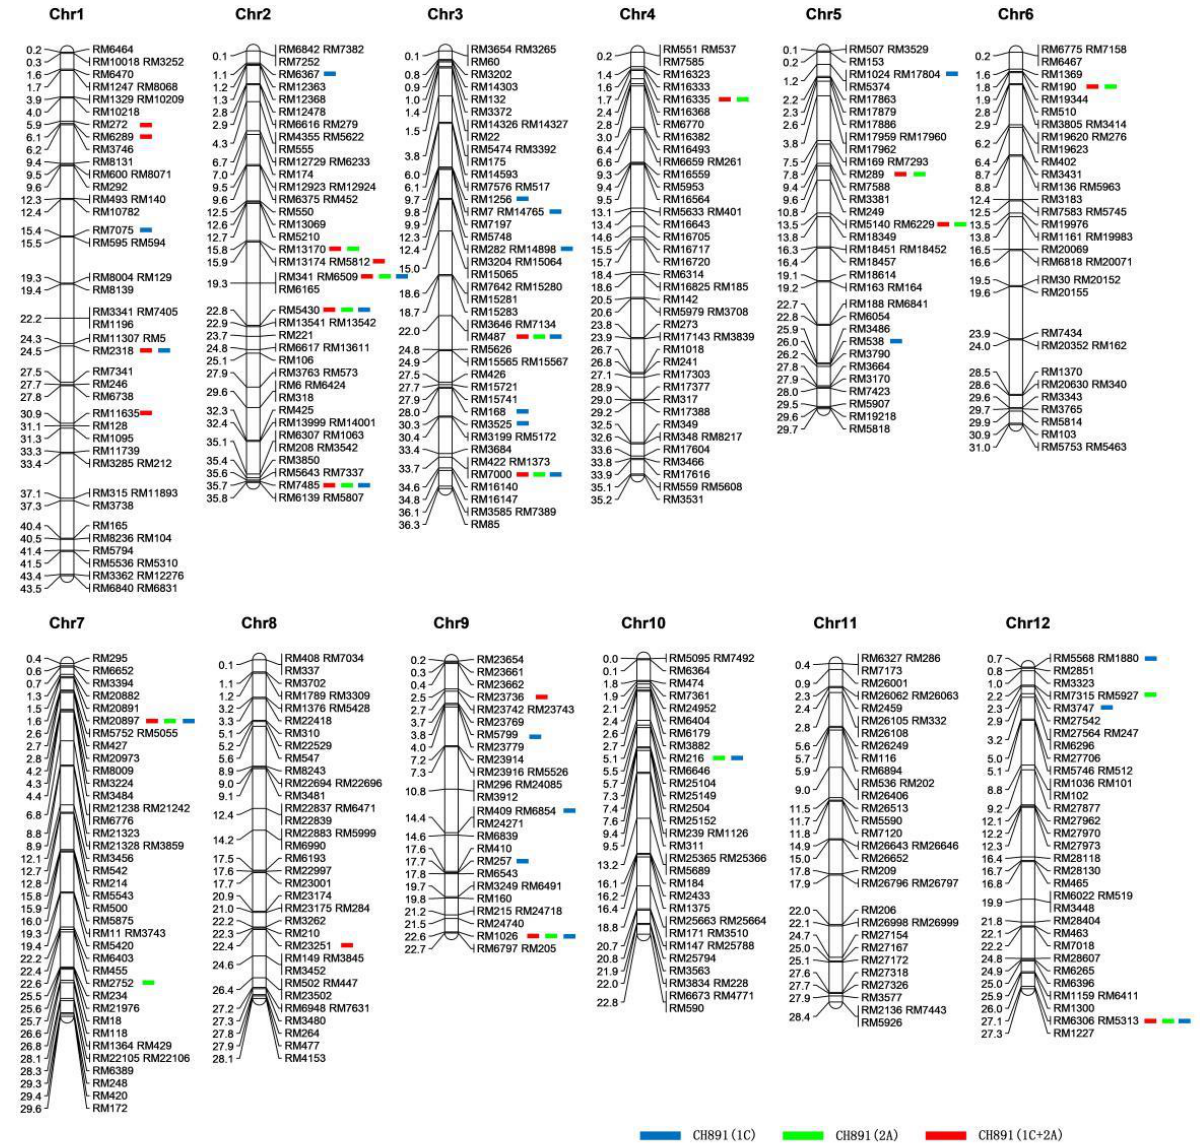
Figure 5. The chromosomal distributions of the 512 microsatellite markers used for genotyping CH891(1C), CH891(2A), CH891(1C+2A), and CH891. Blue, green, and red bars represent the homozygous markers for Minghui 63 genome and/or the Bt genes in three restored lines [CH891(1C), CH891(2A), and CH891(1C+2A)], respectively; the remaining markers were homozygous for the CH891 genome. The scale on the left indicates the physical positions (Mb) of each marker, while the right side of the map shows the name of the microsatellite markers.